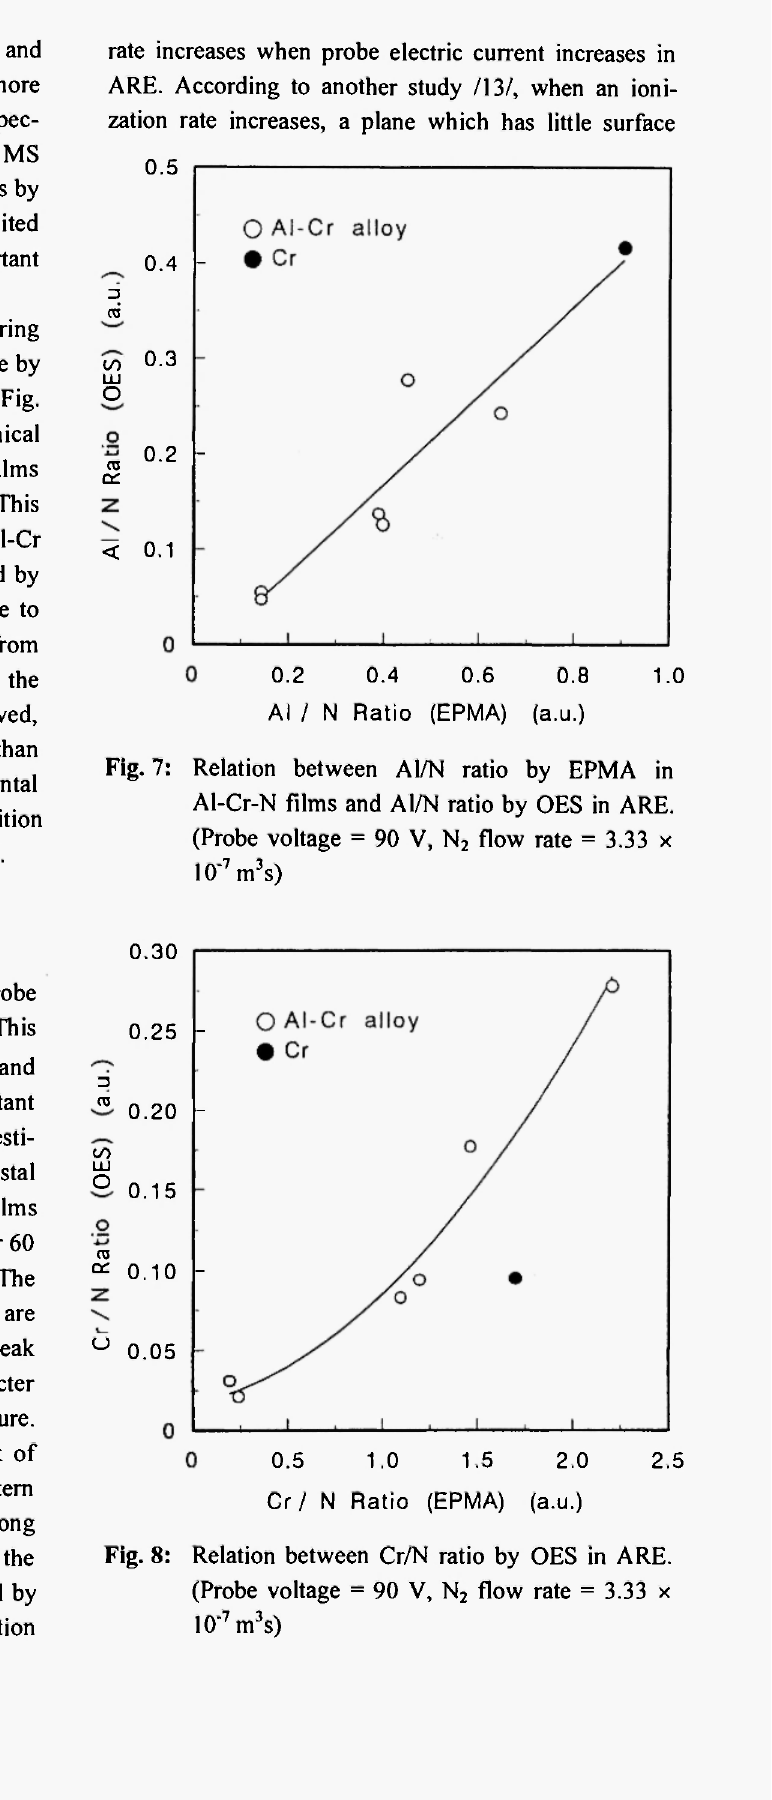
Fig. 7: Relation between Al/N ratio by ΕΡΜΑ in Al-Cr-N films and Al/N ratio by OES in ARE.